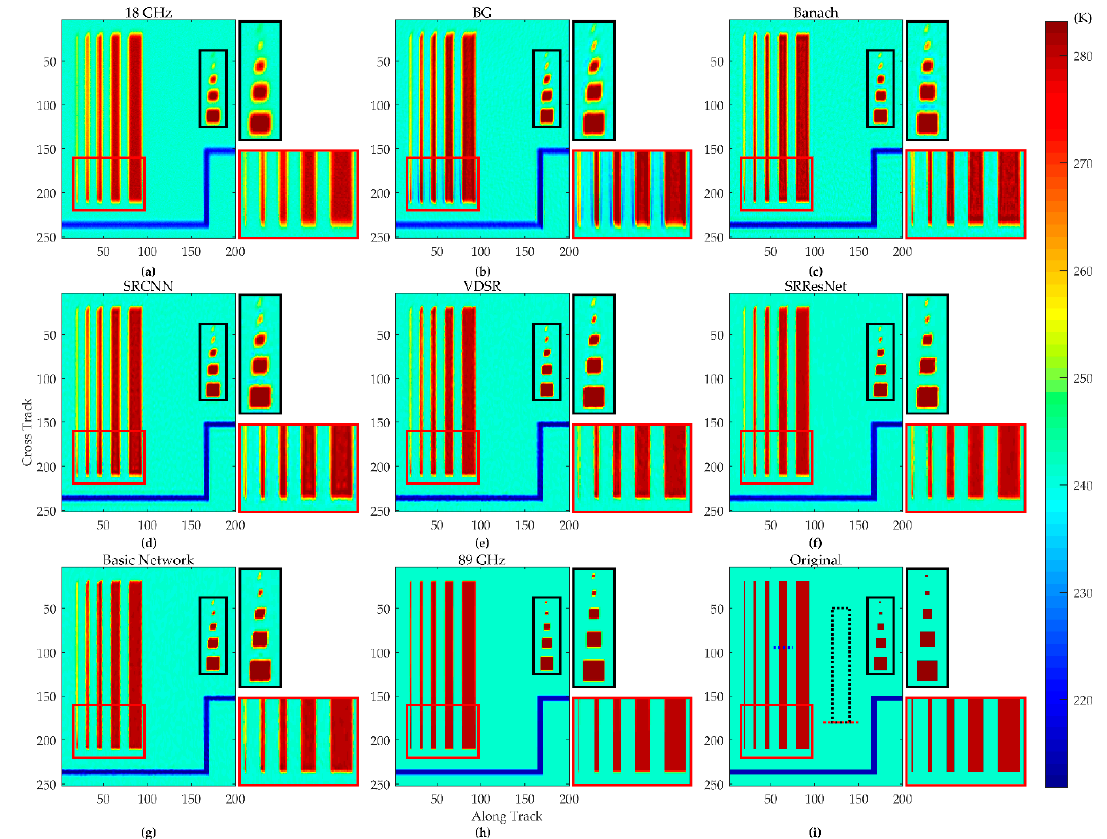
Figure 7. The synthetic scenario and the resolution match results. (a) Simulated 18.7 GHz antenna temperature image; (b) Match result of the Backus–Gilbert (BG) method; (c) Match result of Banach temperature image; ( b ) Match result of the Backus–Gilbert (BG) method; ( c ) Match result of Banach method; (d) Match result of SRCNN; (e) Match result of VDSR; (f) Match result of SRResNet; (g) Match method; ( d ) Match result of SRCNN; ( e ) Match result of VDSR; ( f ) Match result of SRResNet; ( g ) Match result of basic network N b ; (h) Simulated 89 GHz antenna temperature image; (i) Synthetic brightness result of basic network N b ; ( h ) Simulated 89 GHz antenna temperature image; ( i ) Synthetic brightness temperature image. temperature